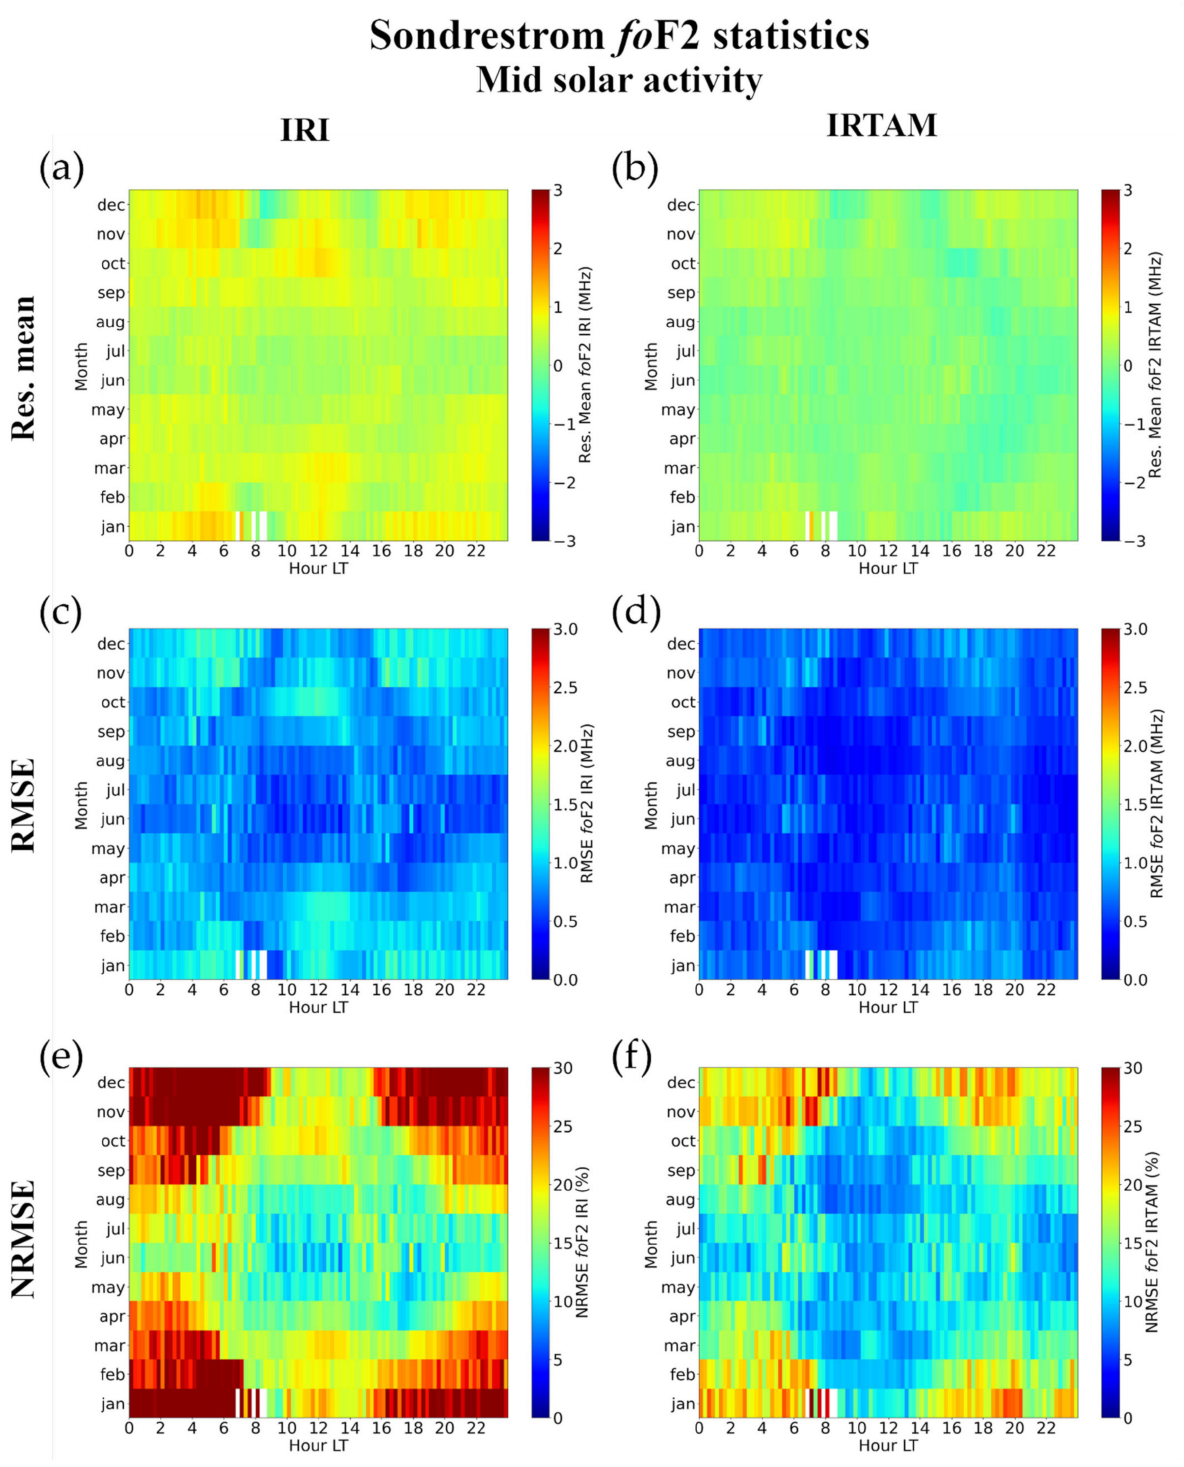
Figure 14. Same as Figure 13 but for MSA